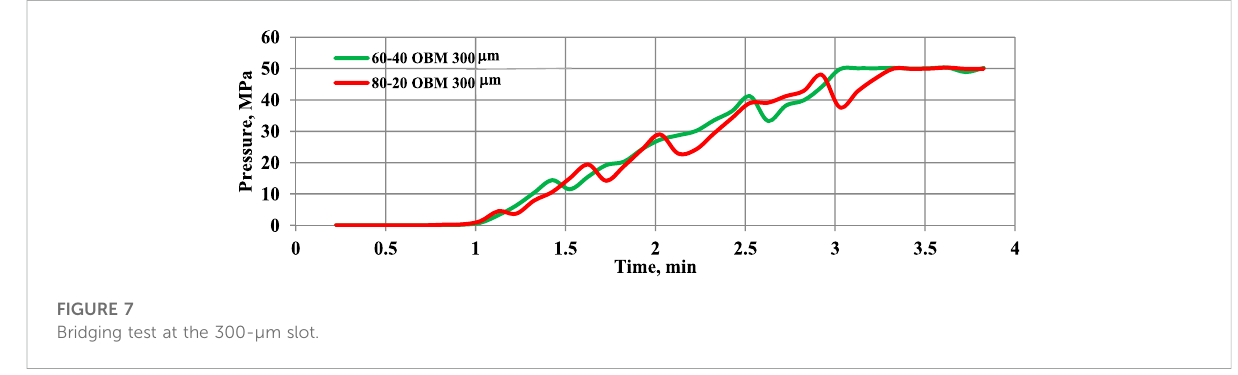
FIGURE 7 Bridging test at the 300- μ m slot.